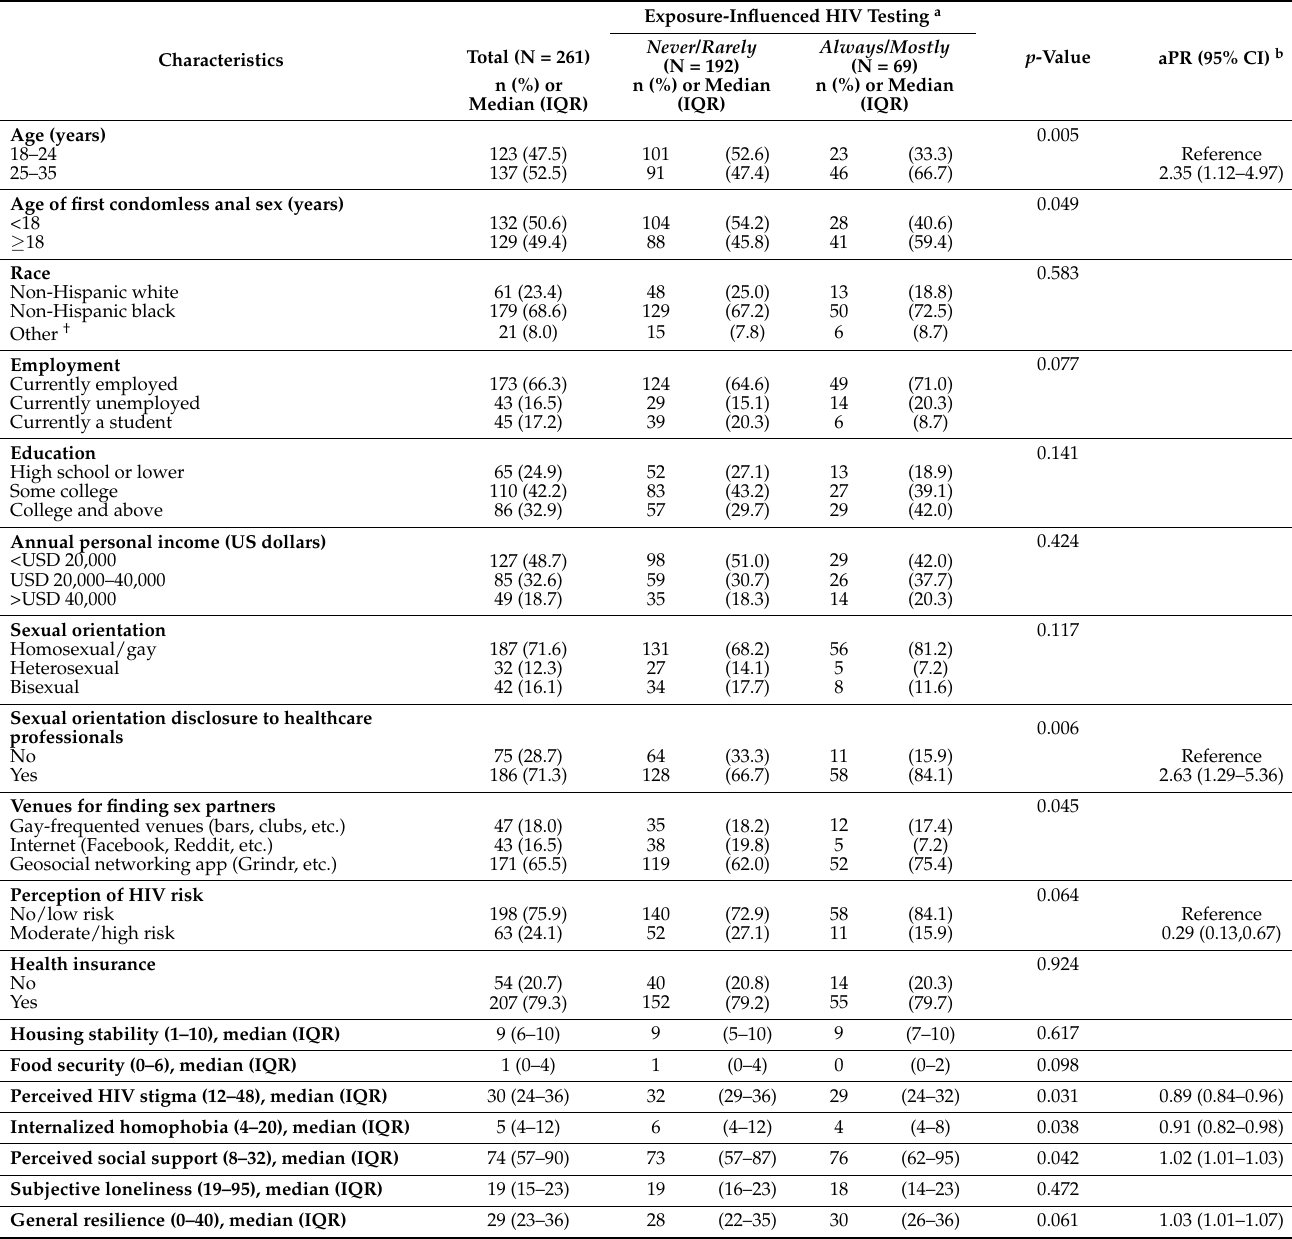
Table 1. Demographic and psychosocial correlates of exposure-influenced HIV testing among a sample of PrEP/PEP-naïve young men who have sex with men recruited from two US urban areas (N =